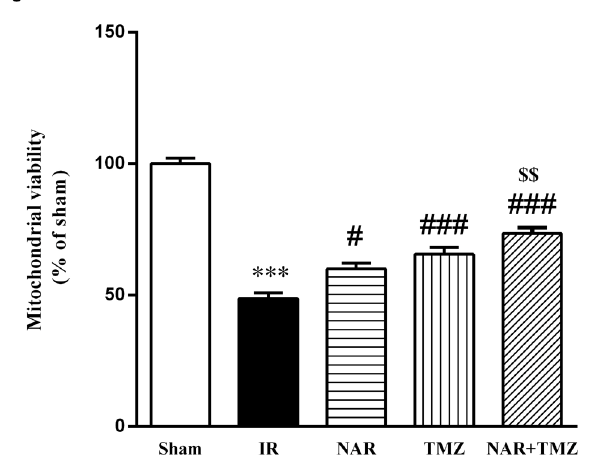
FIGURE 1 - Effect of Naringin (NAR) and Trimetazidine (TMZ) or their combination pretreatment on mitochondrial viability following renal IR injury (mean ± SEM